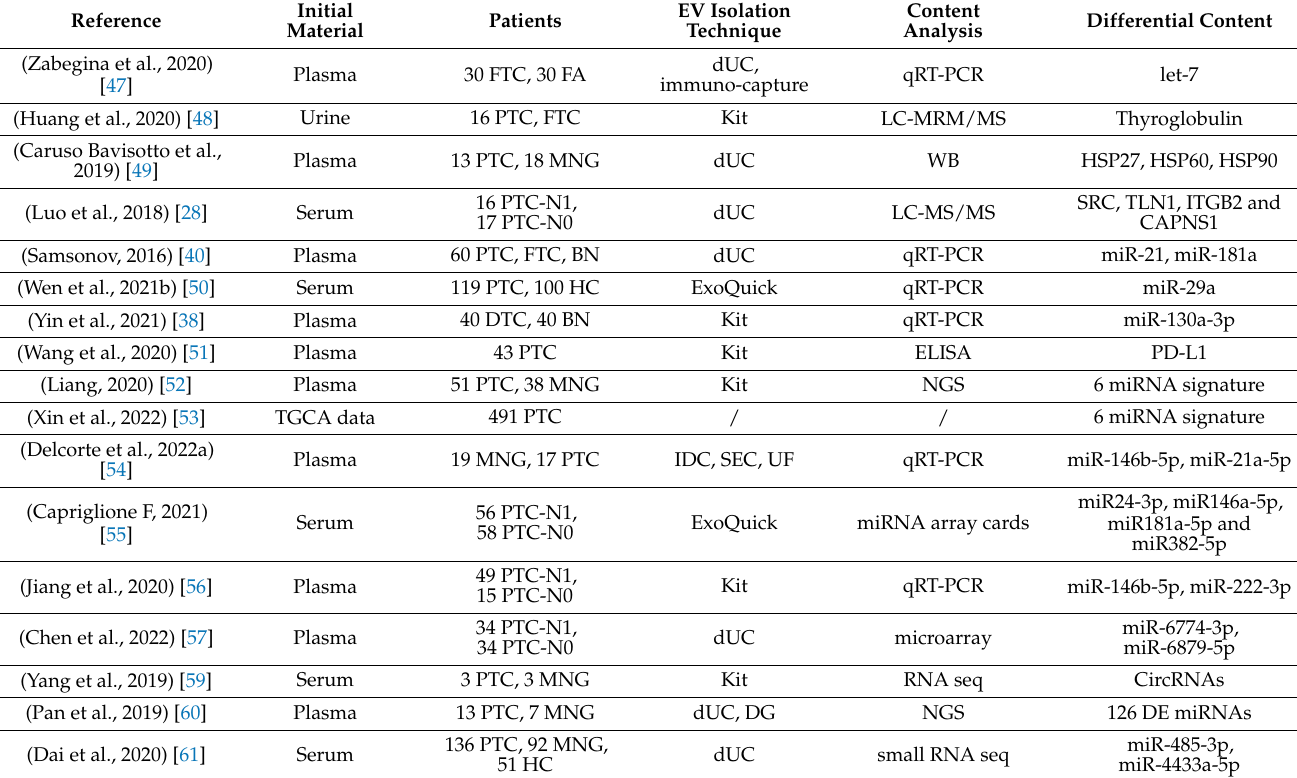
Table 2. List of publications questioning the diagnostic value of EVs in TC. HC—Healthy Con- trols; BN—Benign Nodules; MNG—Multinodular Goiter; PTC—Papillary Thyroid Cancer;